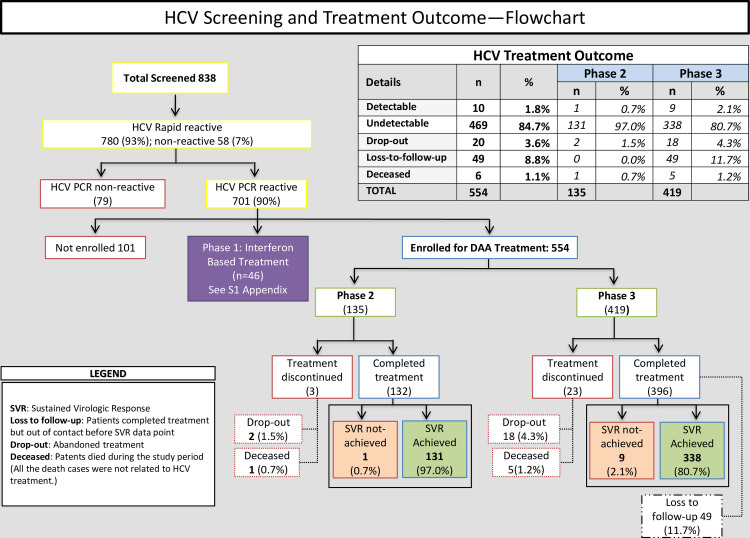
HCV Screening and Treatment.